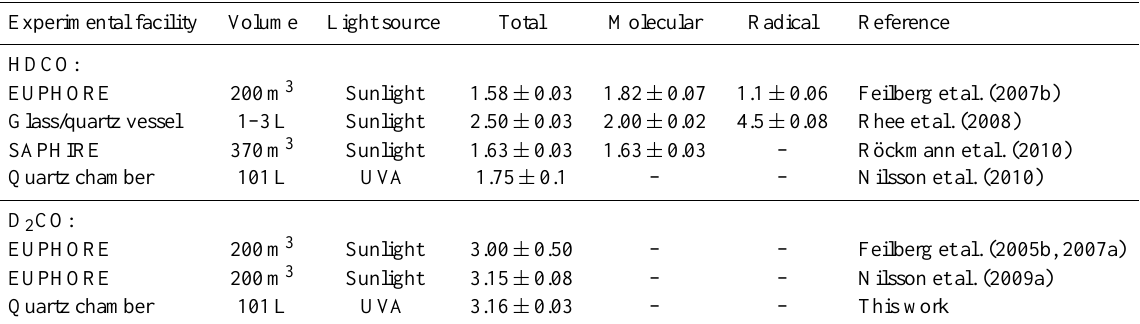
Table 1. Summary of previous experimental results for isotope effects, k( H 2 CO )/k( XDCO ) (X = H or D), of deuterated formaldehyde at atmospheric pressure, and the results obtained at 1000mbar in the present